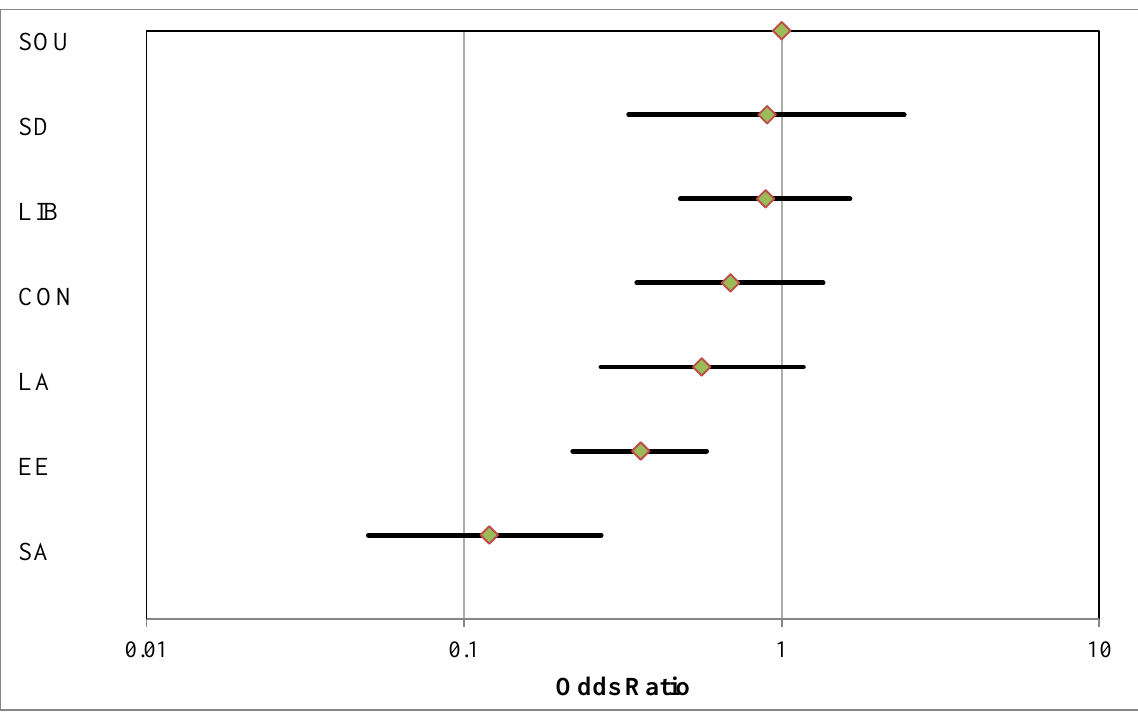
Figure 1. Odds ratios with 95% confidence intervals on the multivariate effect of welfare state regimes on